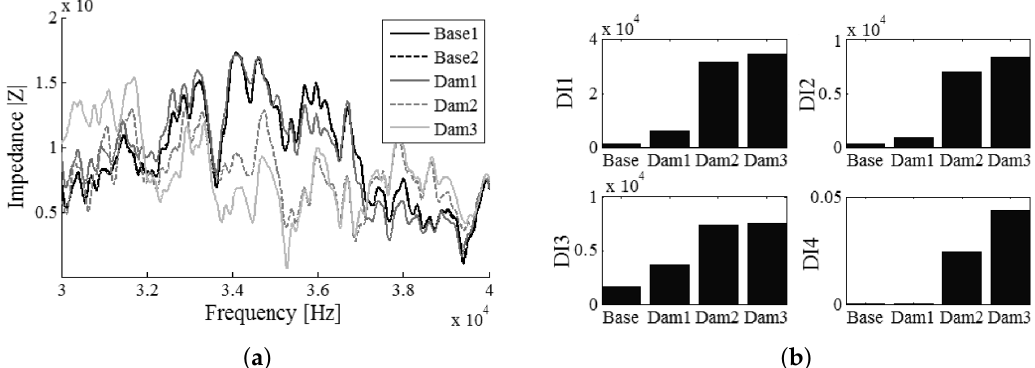
Figure 58. ( a ) The impedance versus frequency plots showing the shifts in the resonant peaks from those in the baseline plots for different damage locations. ( b ) The 4 sets of damage indexes calculated on the basis of different metrics. Reprinted under Creative Commons CC BY license [143].